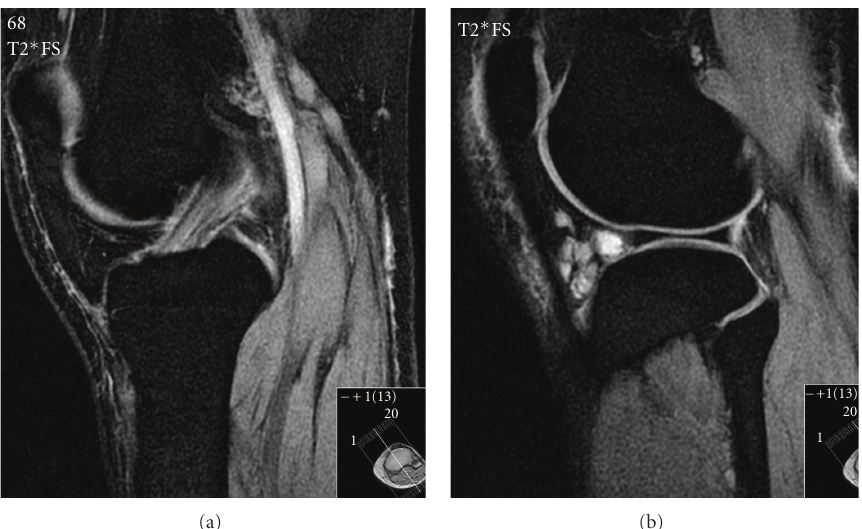
Figure 4: Para-sagittal and sagittal T2 FS MRI scans confirming a normal ACL signal and extensive extension of cystic lesion into Ho ff a’s fat pad.